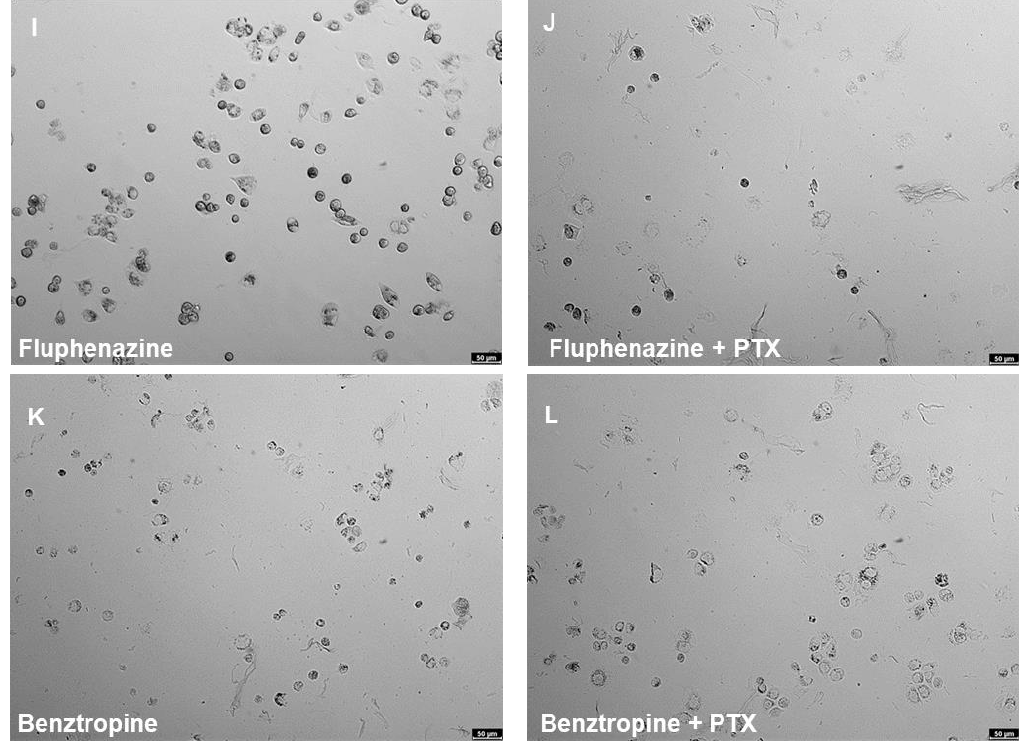
Figure 16. Microscopic cellular visualisation of MCF-7 cells after 48 h of incubation with vehicle ( A ), PTX ( B ), fluoxetine ( C ), fluoxetine + PTX ( D ), sertraline ( E ), sertraline + PTX ( F ), thioridazine ( G ), thioridazine + PTX ( H ), fluphenazine ( I ) fluphenazine + PTX ( J ), benztropine ( K ) and benztropine + PTX ( L ) at concentrations of 4 × IC 50 of each drug. Scale bar: 50 µm.